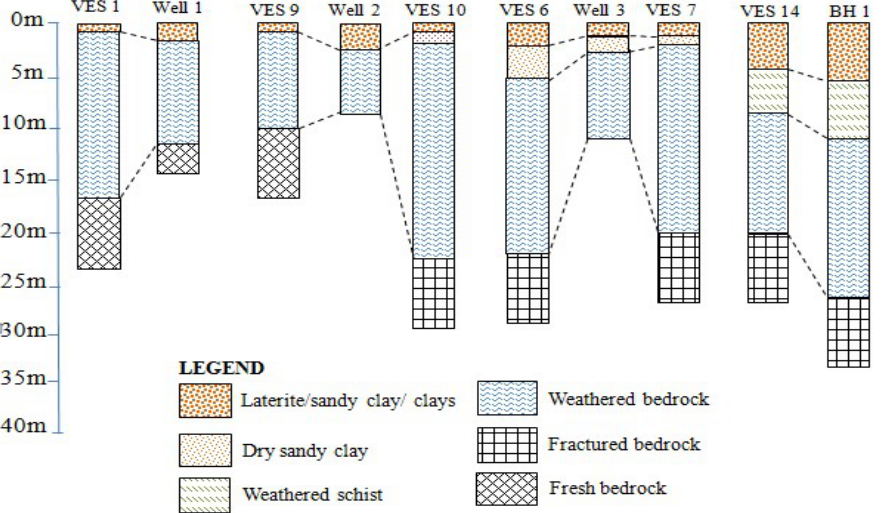
Figure 5. Well and borehole logs correlated with VES interpretation results.